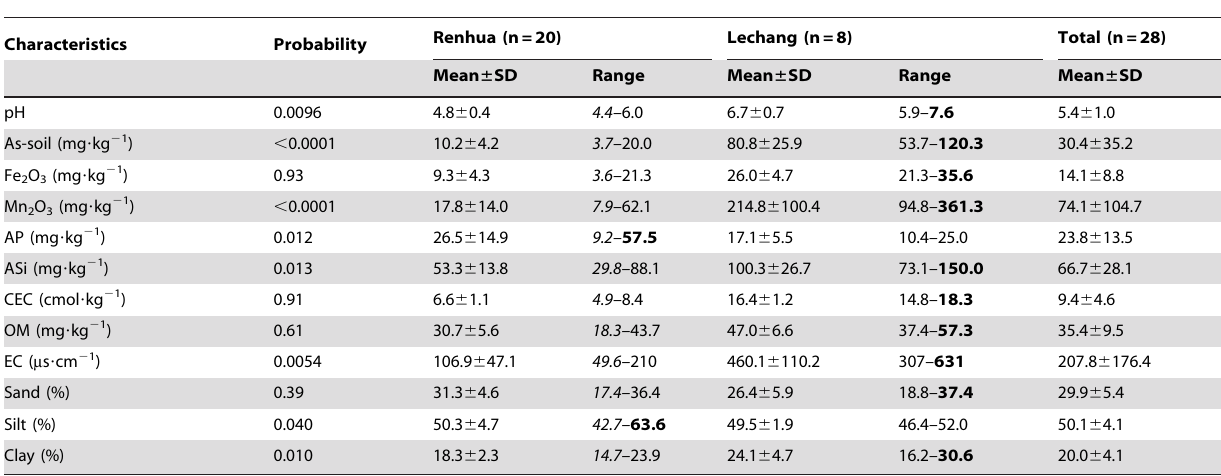
Table 1. Descriptive statistics of soil properties of Renhua and Lechang.